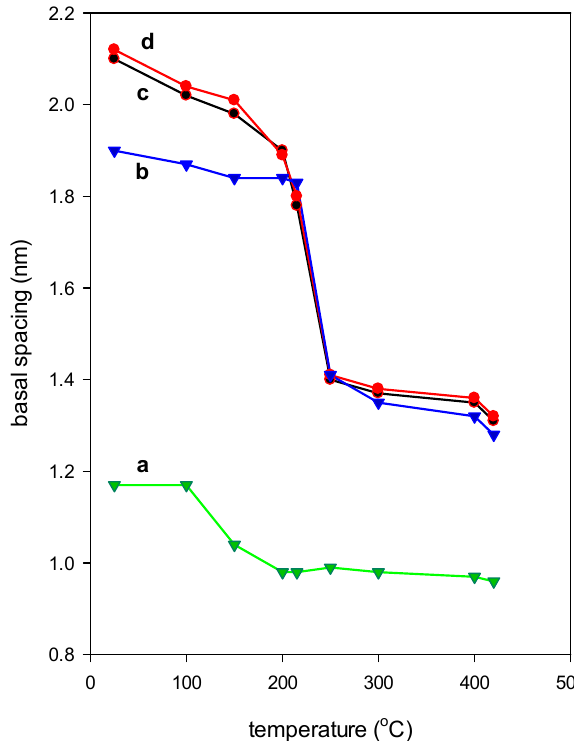
Figure 9. Variation of the basal spacing of starting ( a ) cloisite-Na clay and derived organoclays ( b ) C 16 OH-CN, ( c ) C 16 Br-CN, and ( d ) C 16 Cl-CN preheated at different temperatures. ( b ) C 16 OH-CN, ( c ) C 16 Br-CN, and ( d ) C 16 Cl-CN preheated at di ff erent